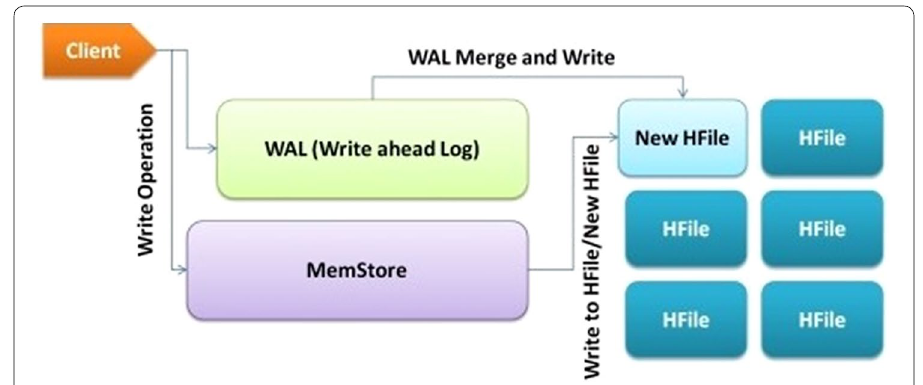
Fig. 3 Hbase data